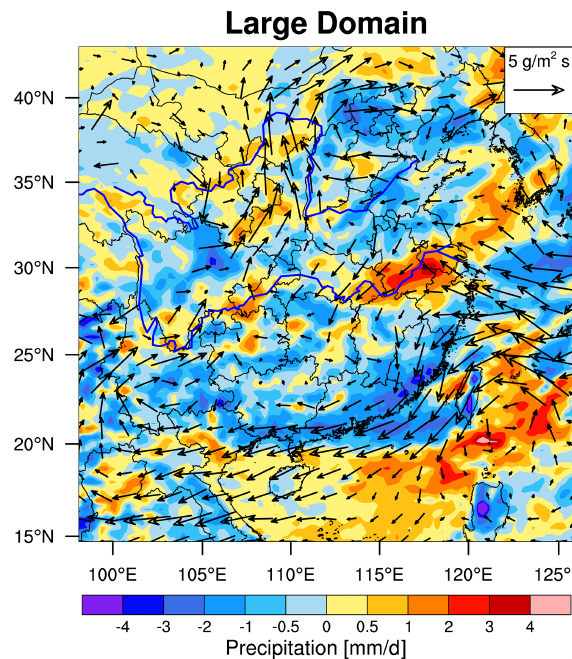
Figure 12. The same as Fig. 8, but from the large-domain simula-